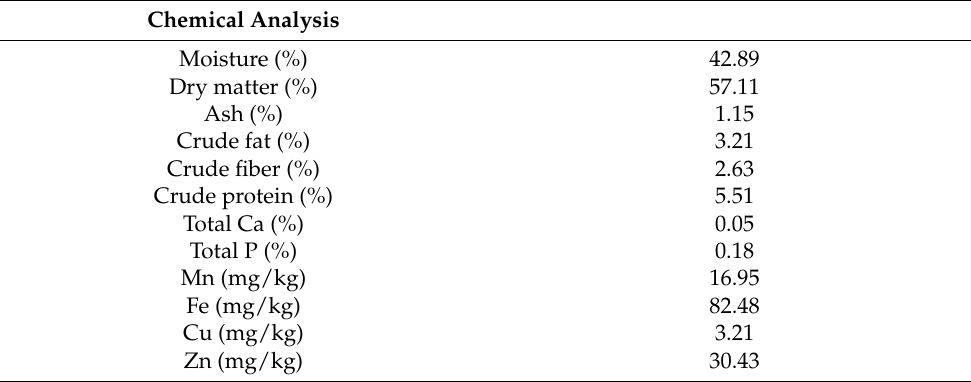
Table 1. Chemical analysis of the examined silage.